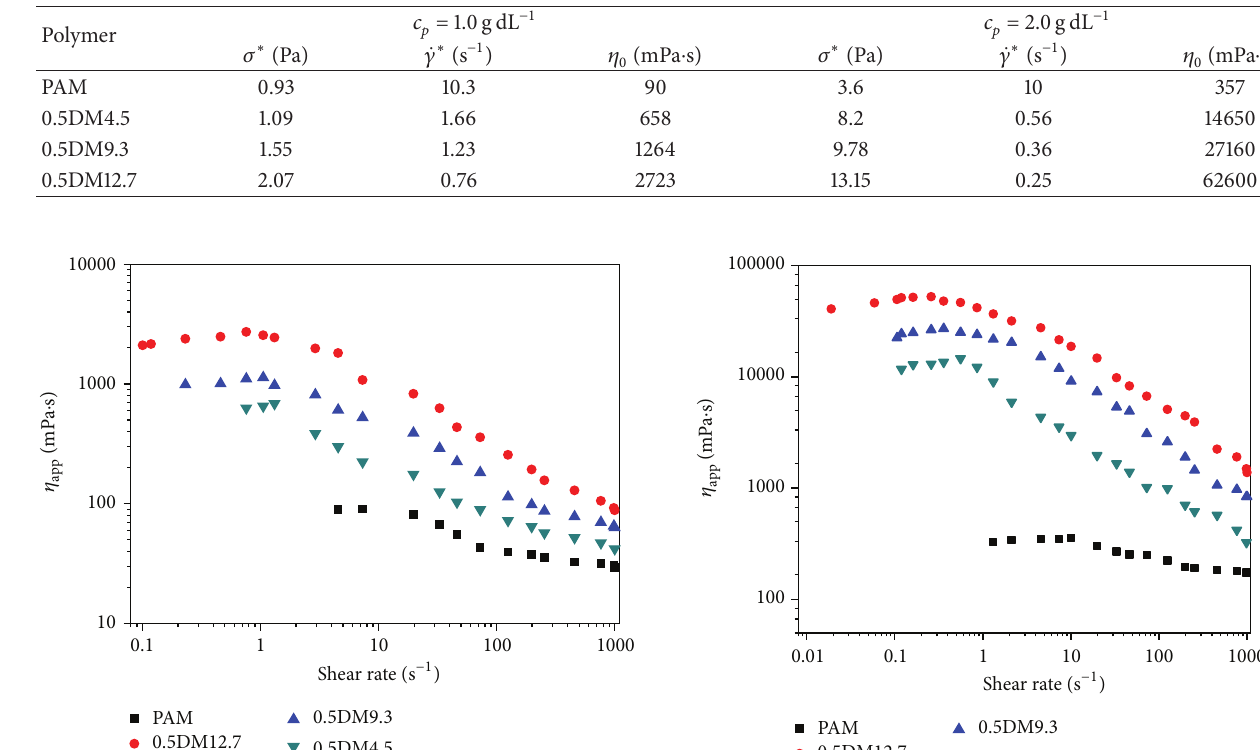
Figure 8: Variation of apparent viscosity as a function of shear rate for PAM, 0.5DM12.7, and 0.5DM4.5 ( 𝑐 𝑝 = 2.0 gdL −1 , 𝑇 = 25 ∘ C).